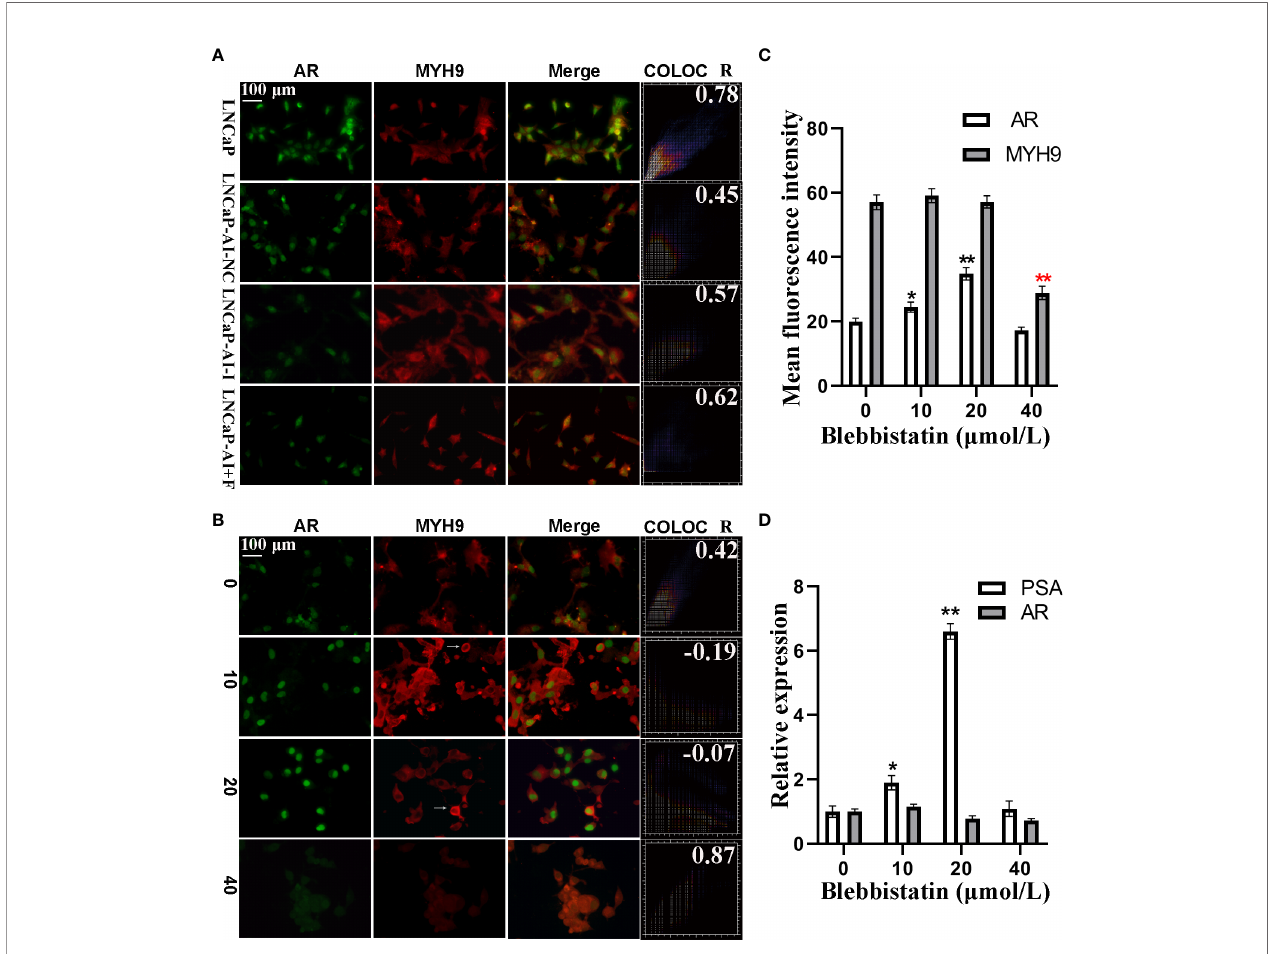
FIGURE 8 | AR nuclear translocation was retarded by MYH9 in LNCaP-AI cells. (A) AR (green) and MYH9 (red) were colocalized in the four PCa cells, as detected by immuno fl uorescence. (B – D) LNCaP-AI cells were treated with blebbistatin at 0, 10, 20 and 40 m M for 2 h. The subcellular localization of AR (green) and MYH9 (red) was visualized using fl uorescence microscopy (B) . The mean fl uorescence intensity of AR and MYH9 in (B) was calculated and presented in (C) . AR and MYH9 mRNA expression treated with blebbistatin was detected by qRT-PCR and shown in (D) . The results are expressed as the mean ± SE of three biological replicates. The arrow pointing to MYH9 indicates its assembly in the perinuclear area. The scale bar in the upper left corner is 100 m m (40×). COLOC presents AR and MYH9 colocalization and R represents Pearson ’ s R value (above threshold); *P<0.05, **P<0.01; one-way ANOVA followed by Dunnett ’ s test compared with the blebbistatin untreated group,